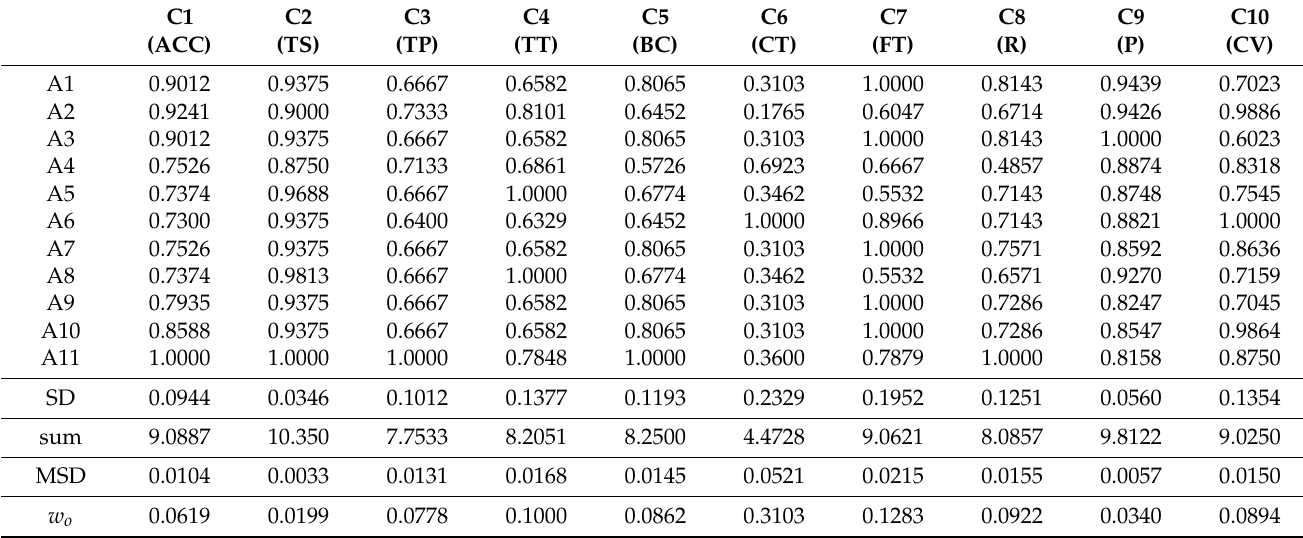
Table 6. The MSDM method’s weighting